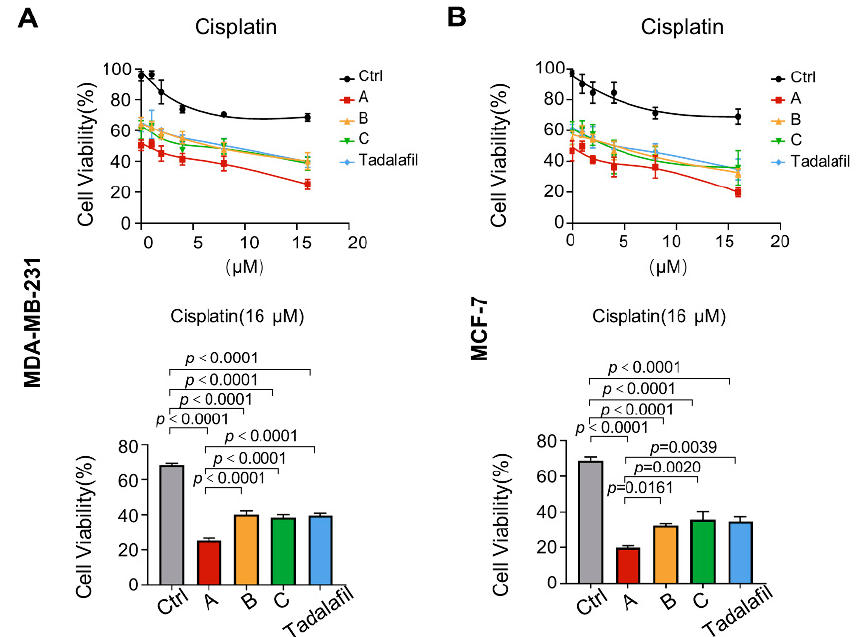
Figure 9. Chemicals A, B, and C enhance the inhibitory effects of cisplatin on cell viability. ( A , B )